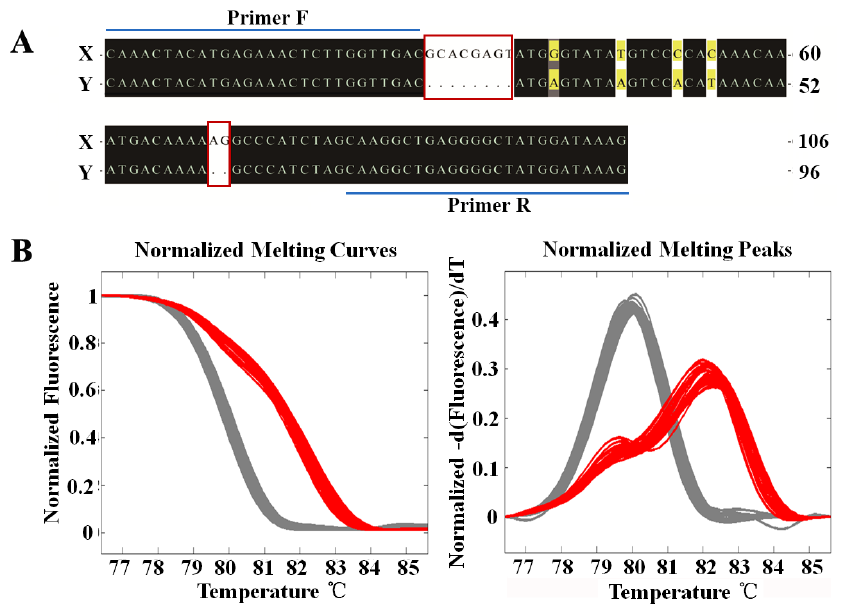
Figure 2. Screening and validation of a sex-specific marker. ( A ) Sequence differences of a sex- specific marker in S. chuatsi . Indels are marked with the red boxes; SNPs are marked with a yellow background. The line area indicates the location of upstream and downstream primers. ( B ) The HRM method was used to classify wild females ( n = 38) and males ( n = 31). The left and right figures show the normalized melting curves and normalized melting peaks of amplified PCR products, respectively. The gray curve represents females, while the red curve represents